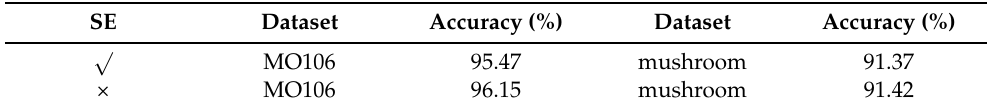
Table 5. Impact of SE module on the